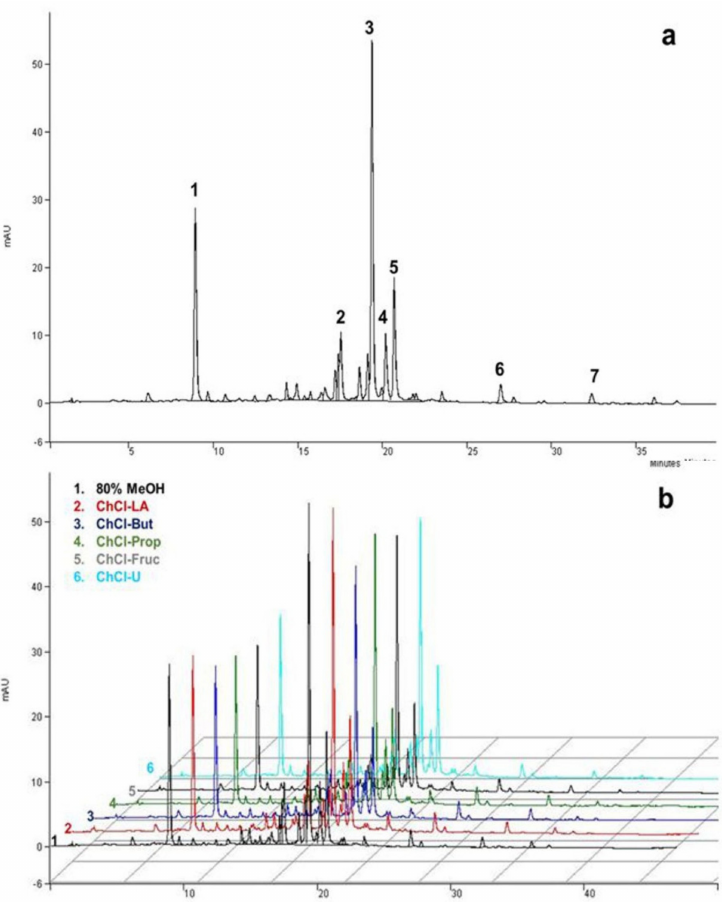
Figure 2. Typical HPLC-UV chromatograms of A. millefolium extracts recorded at 325 nm under optimal chromatographic conditions: ( a ) methanolic; ( b ) compression between methanolic and NADES extracts: (1) chlorogenic acid; (2) luteolin-7- O -glucoside; (3) DCQA isomer I; (4) apigenin-7- O -glucoside; (5) DCQA isomer II; (6) luteolin; (7)